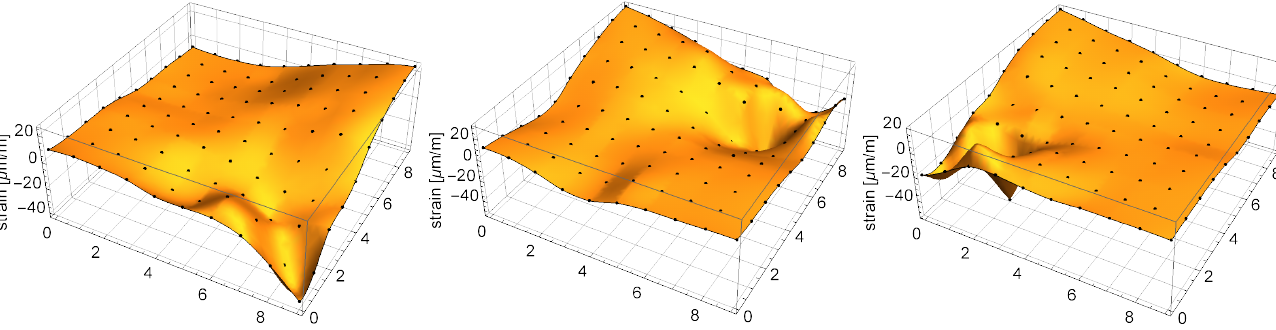
Figure 6. Response surfaces that describe static sensor responses to the constant gravity load of a 0.265 kg mass placed on the plate: ( a ) sensor A; ( b ) sensor B; ( c ) sensor C. The surfaces are interpolated based on the explicitly marked 10 × 10 point